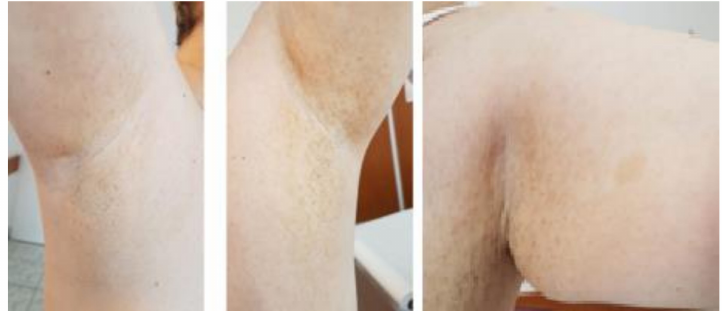
Figure 1. Bilateral axillary freckling and and caf é au lait spot on the left arm (scale